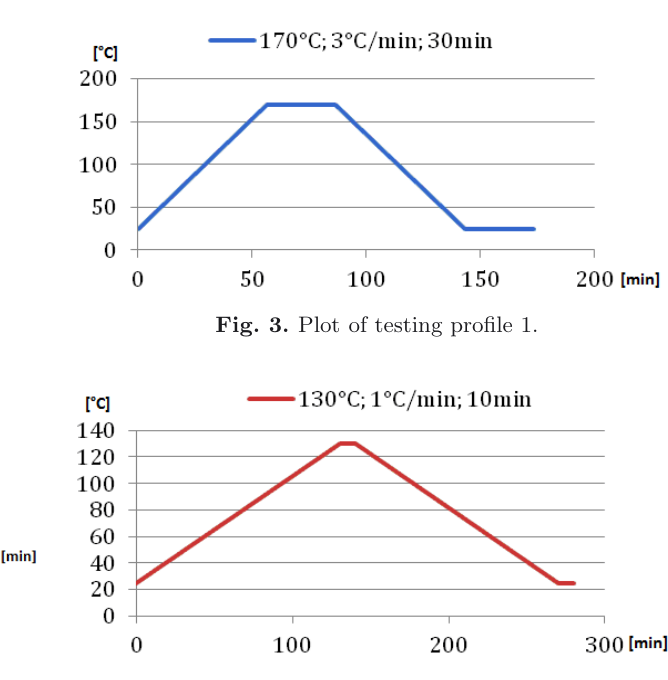
Fig. 4. Plot of testing profile